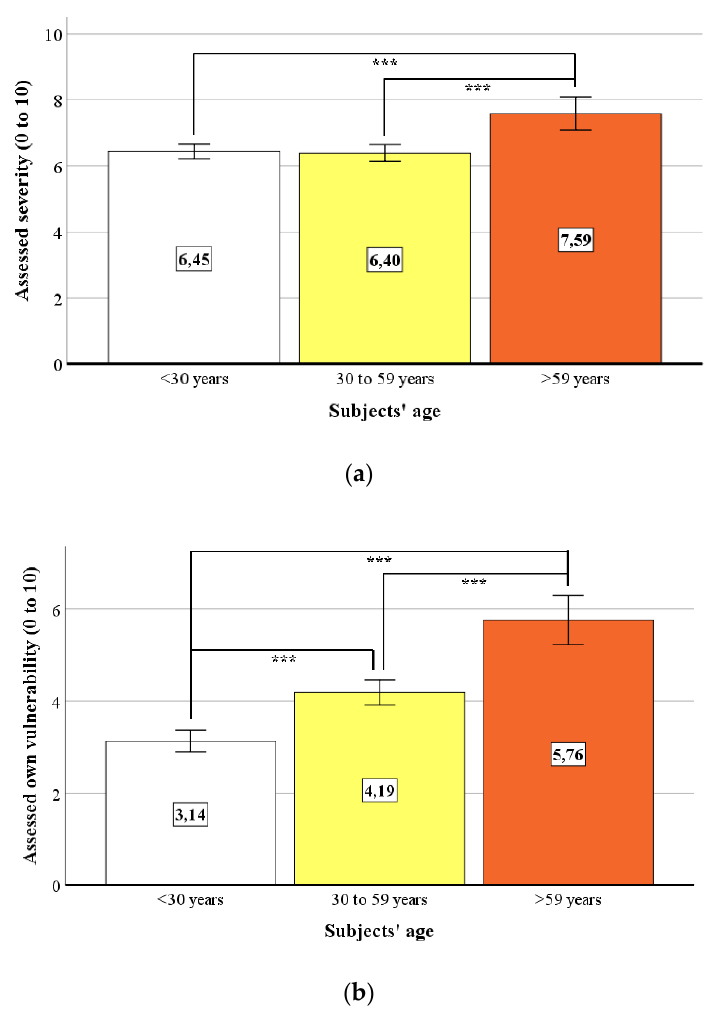
Figure 5. Age-dependent assessments of COVID-19: ( a ) Assessment of COVID-19 ′ s severity (*** = p < 0.001); ( b ) assessment of subjects’ own vulnerability to COVID 19 (*** = p < 0.001).